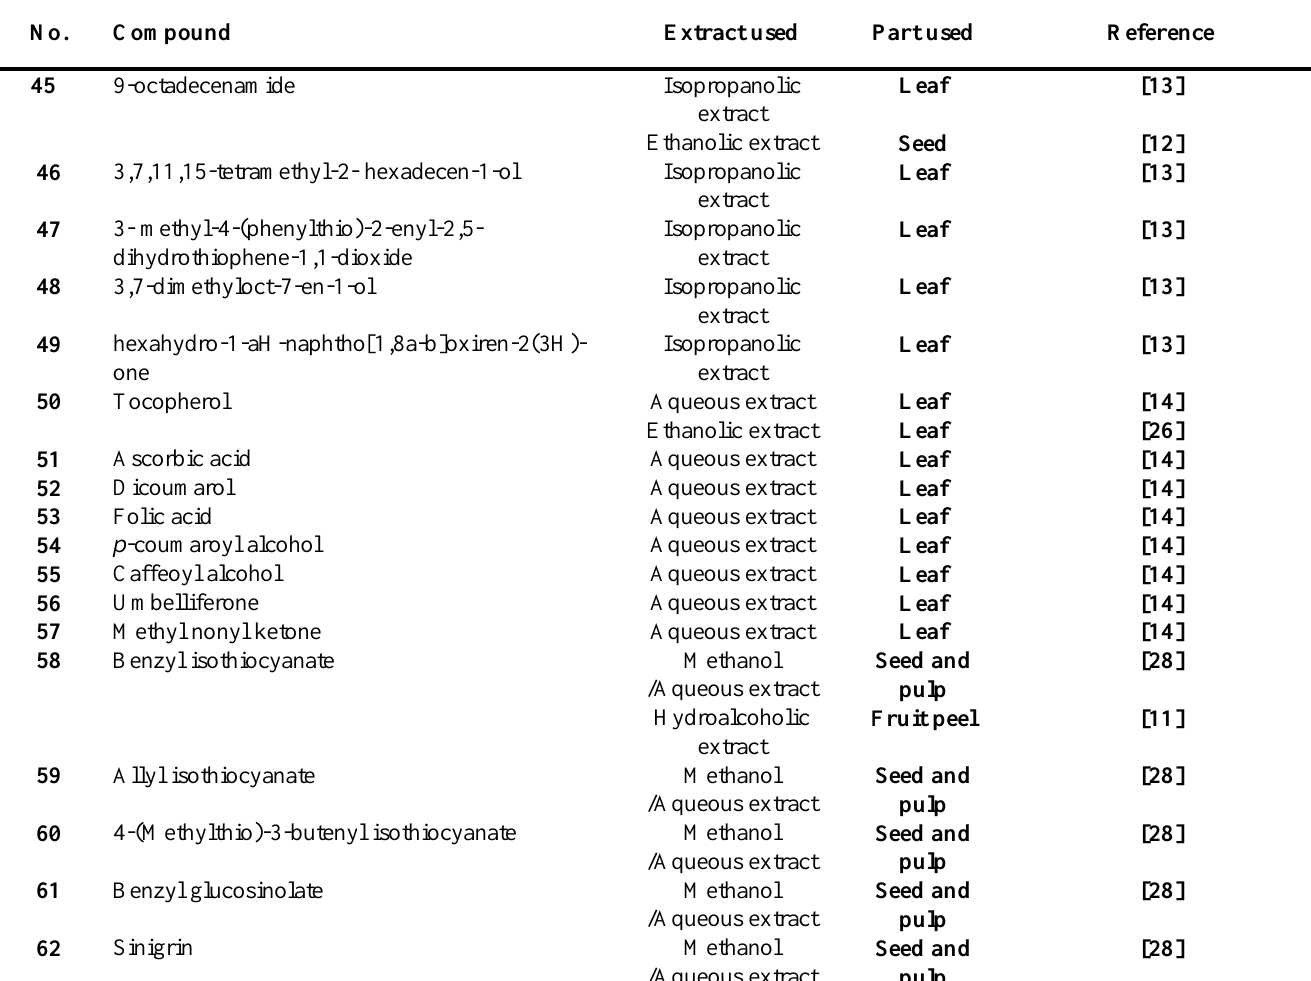
` Table 6. Miscellaneous compounds reported in C. papaya No.